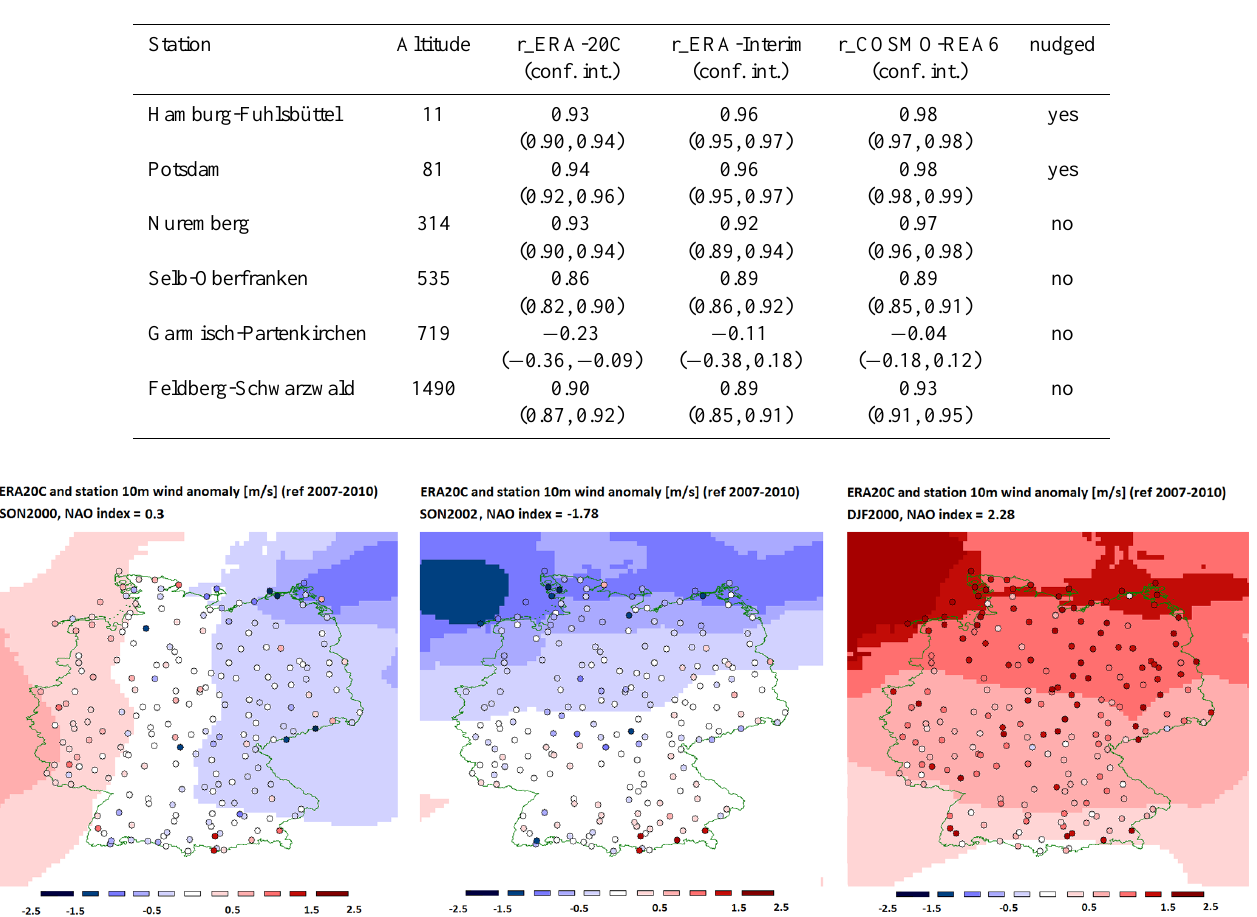
Table 3. Pearson correlation coefficient together with its 1 σ -confidence interval, between mean monthly wind speeds from selected station observations and matching grid cells from interpolated ERA-20C, interpolated ERA-Interim, and COSMO-REA6. Note that for ERA-20C and ERA-Interim, all station observations are independent. For COSMO-REA6, station observations are assimilated (nudged) as indicated in the last column.